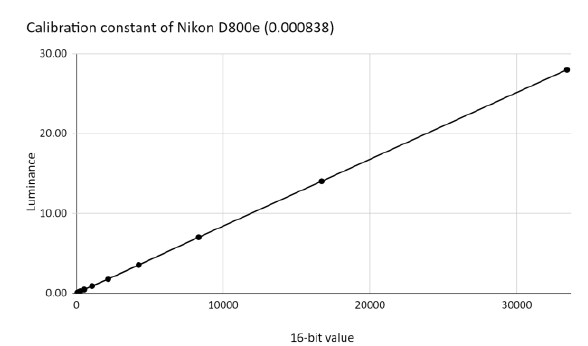
Figure 4. The illustration of Nikon D800e calibration constant. Luminance value in cdm -2 .